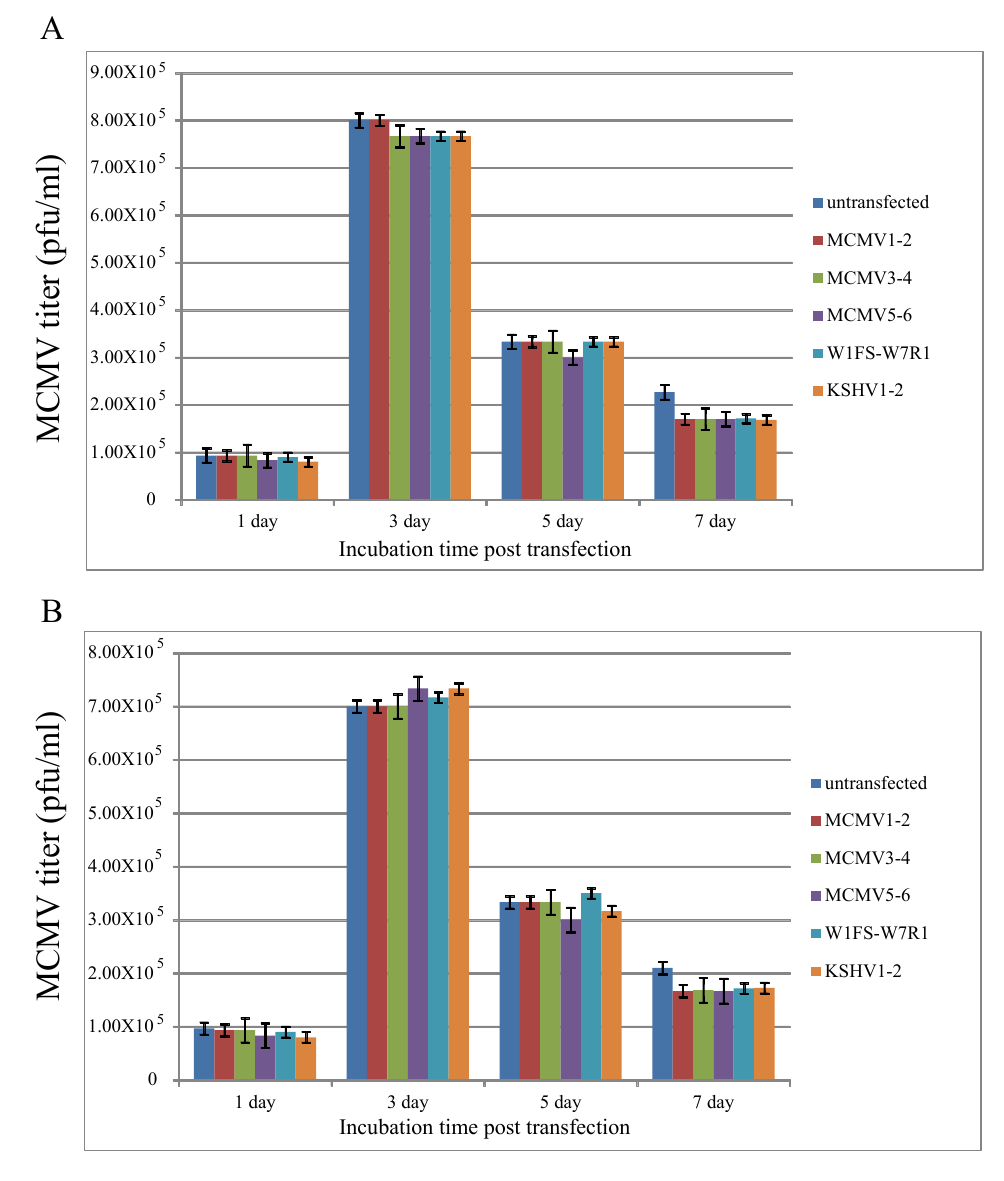
Figure 5. MCMV infection was prior to TALEN plasmid transfection. Viral titers were determined at 1, 3, 5 and 7 days post transfection using lipofectamine ( A ) or NKS11 ( B ), respectively. All the data are expressed by columns (mean ± standard